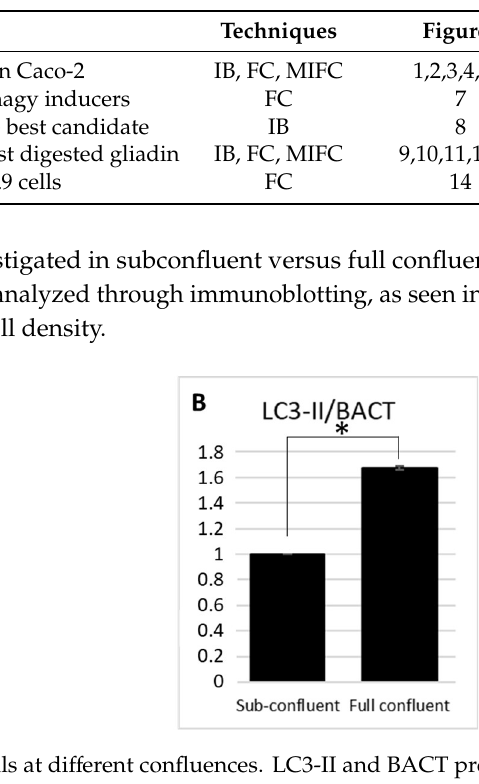
Table 1. Schematic representation of the experimental plan and the techniques adopted in each step.